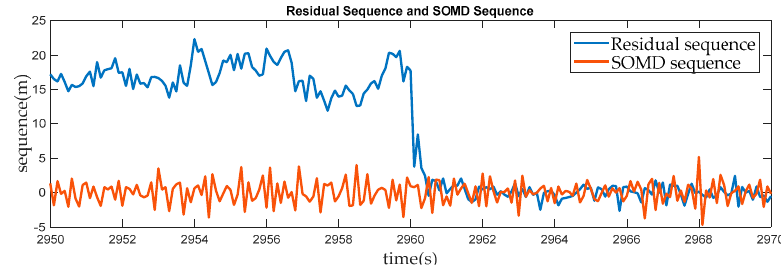
Figure 9. Comparison of the residual sequence and SOMD sequence of satellite #24 when the number of visible satellites changes from 1 to 8 at the 2960-th second.